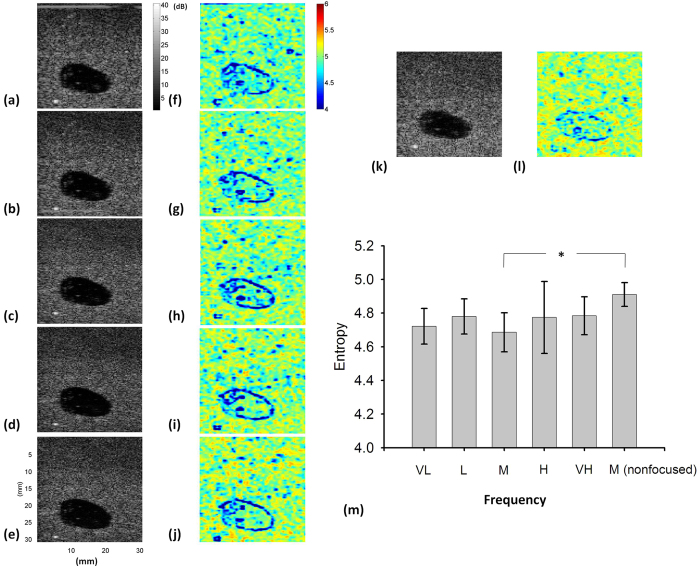
(a–e) B-mode images of the Type-D breast phantom with a mass at frequencies of 5, 5.5, 6, 7.5, and 8 MHz (SL = 1; scanned at a focus of 2 cm). (f–j) Entropy images corresponding to (a–e). (k–l) B-mode and entropy images scanned using 6 MHz and a focal length of 3 cm. The dimensions for all images are the same. The grayscale and color bars represent the pixel values (the brightness) of the B-mode and entropy images, respectively. (m) Entropy of the mass as a function of different settings (the “*” symbol indicates a p value < 0.05). Data were expressed by mean ± standard deviation.